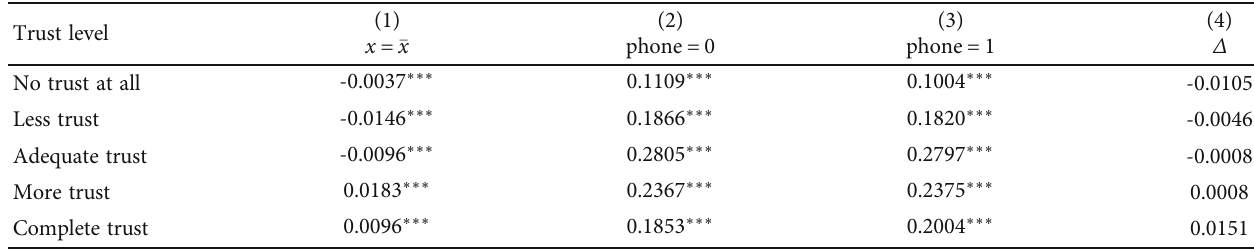
Table 5: Discrete marginal e ff ects of smartphone usage.